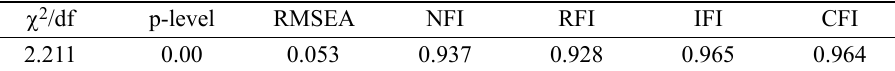
Table 1. Fit indices of the measurement model